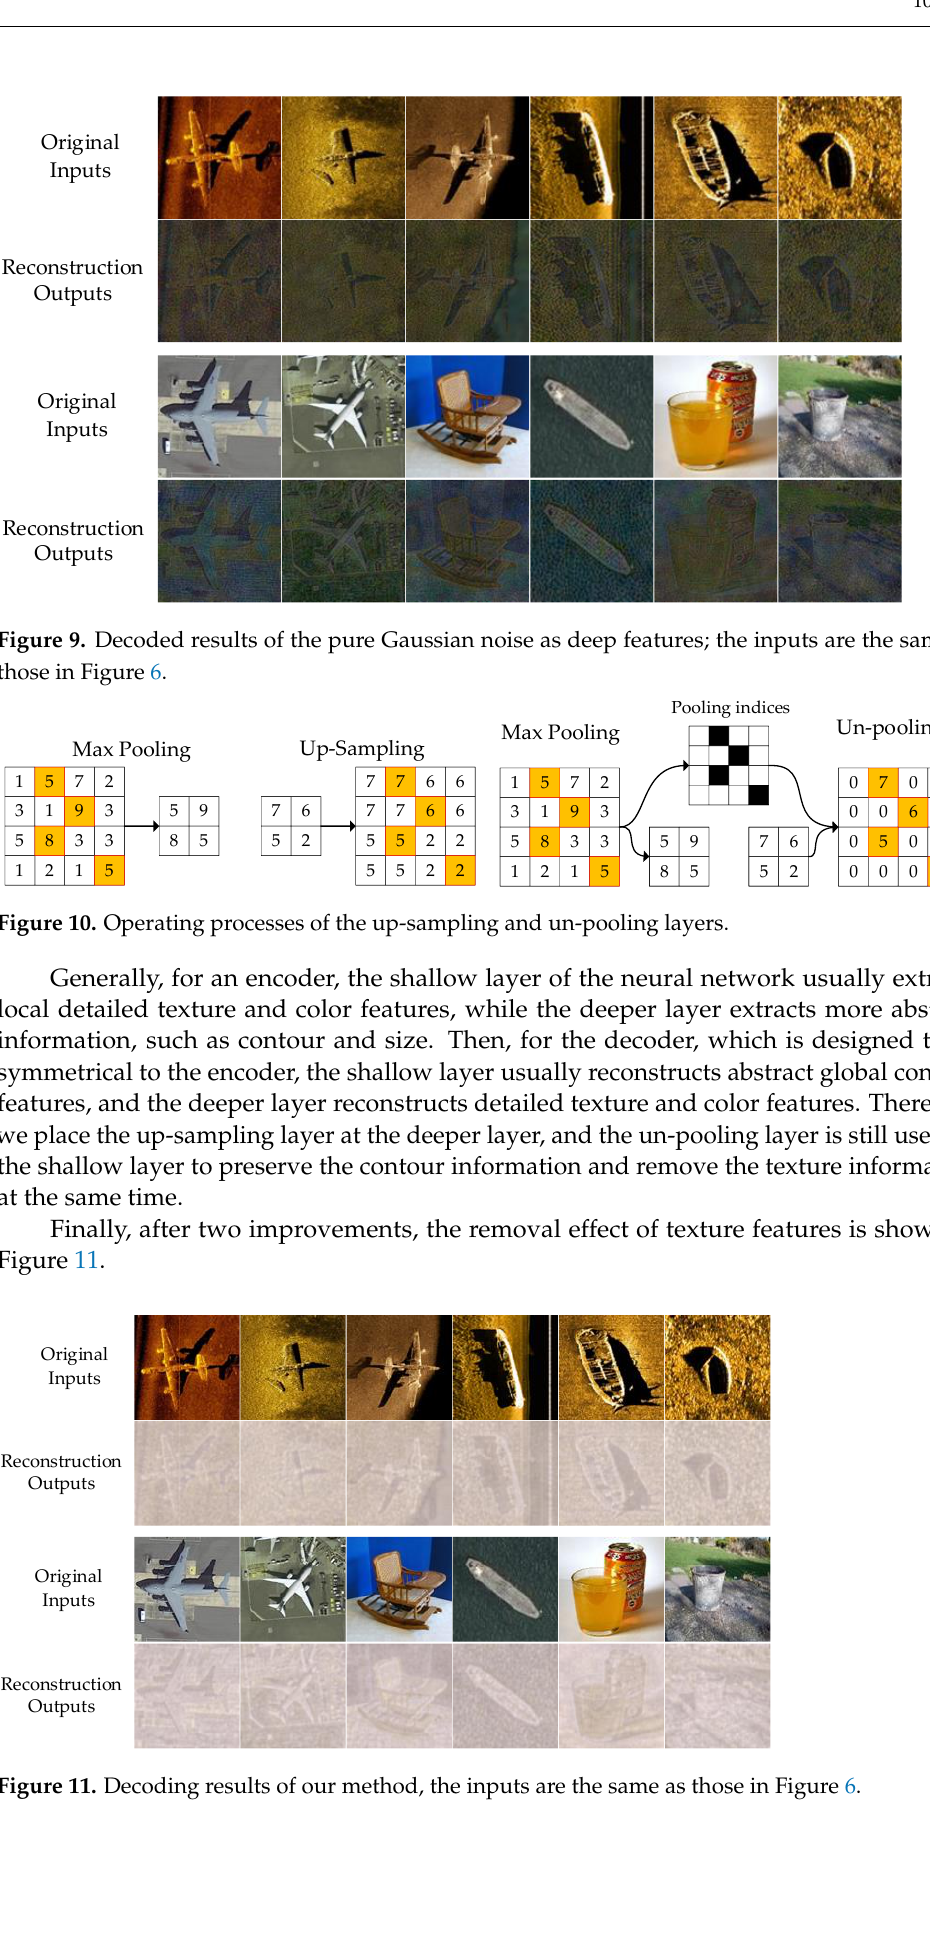
L o ss Figure 12. Network structure of our method. 3. Results We verify our proposed method by conducting experiments on the side-scan sonar image classification task and the forward-looking sonar image target detection task. For the experiments on the side-scan sonar image classification task, we also use the super- vised transfer learning method and unsupervised transfer learning method to evaluate the effectiveness. 3.1. Supervised Transfer Learning Experiments of the Side-Scan Sonar Image Classification Task 3.1.1. Source Domain Dataset Because the visual angles of remote sensing images and side-scan sonar images are similar, the domain gap will be smaller after removing texture features, which is more conducive to the transfer of knowledge; thus, we select several remote sensing image datasets as the source domain datasets, namely DOTA [44] UCAS-AOD [45], NWPU VHR-10 [46], RSOD-Dataset [47], and NWPU RESISC45 [48]. As four of them are designed for detection tasks, we cut their images into image pieces based on the provided bounding boxes. Then, we filter out small image pieces and randomly delete some pieces to ensure the approximate balance of the dataset. Finally, the constructed source domain dataset contains three categories: aircraft (1313 samples), ship (601 samples), and others (2080 samples). The ‘ others ’ category consists of samples from the five datasets that do not correspond to aircrafts or ships, including trucks, cars, overpasses, beaches, etc.